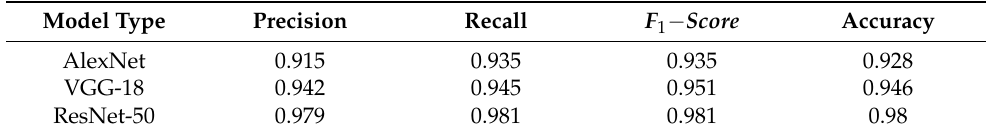
Table 4. Report on comparative performance analysis. Model